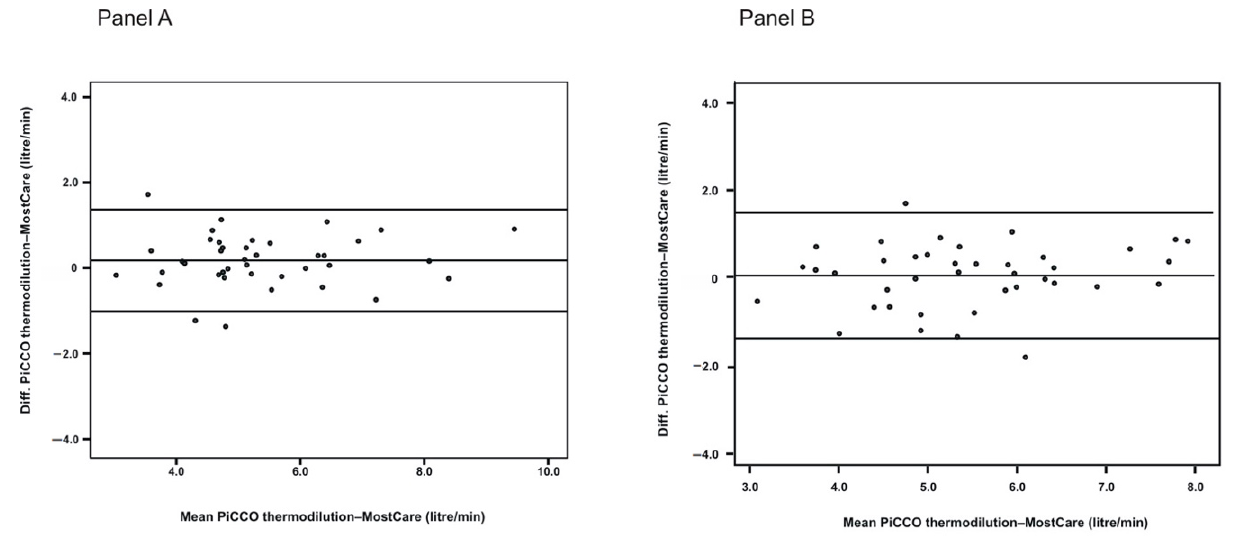
Figure 2. ( Panel A ) Bland-Altman plot at T1; the horizontal lines on the scatterplot represent the bias and the limits of agreement (mean bias ± 2 Standard Deviations). ( Panel B ) Bland-Altman plot at T2; the horizontal lines on the scatterplot represent the bias and the limits of agreement (mean bias ± 2 Standard Deviations).